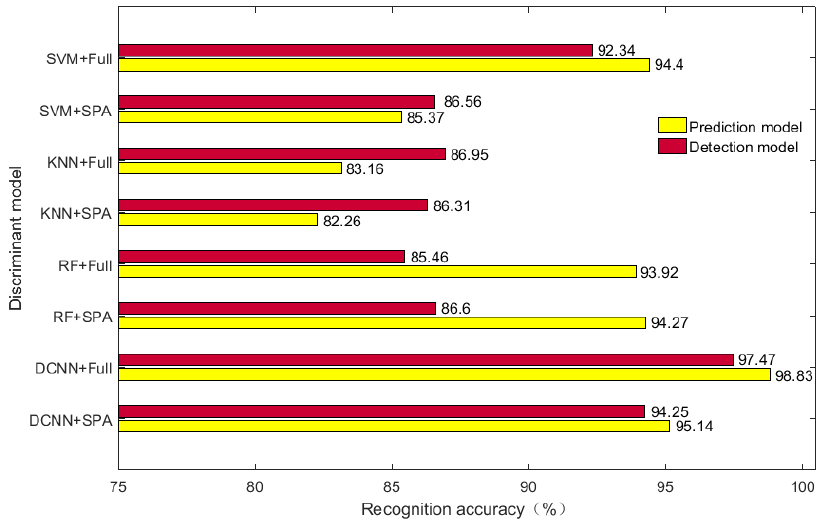
Figure 12. Viability prediction results of different combination models.